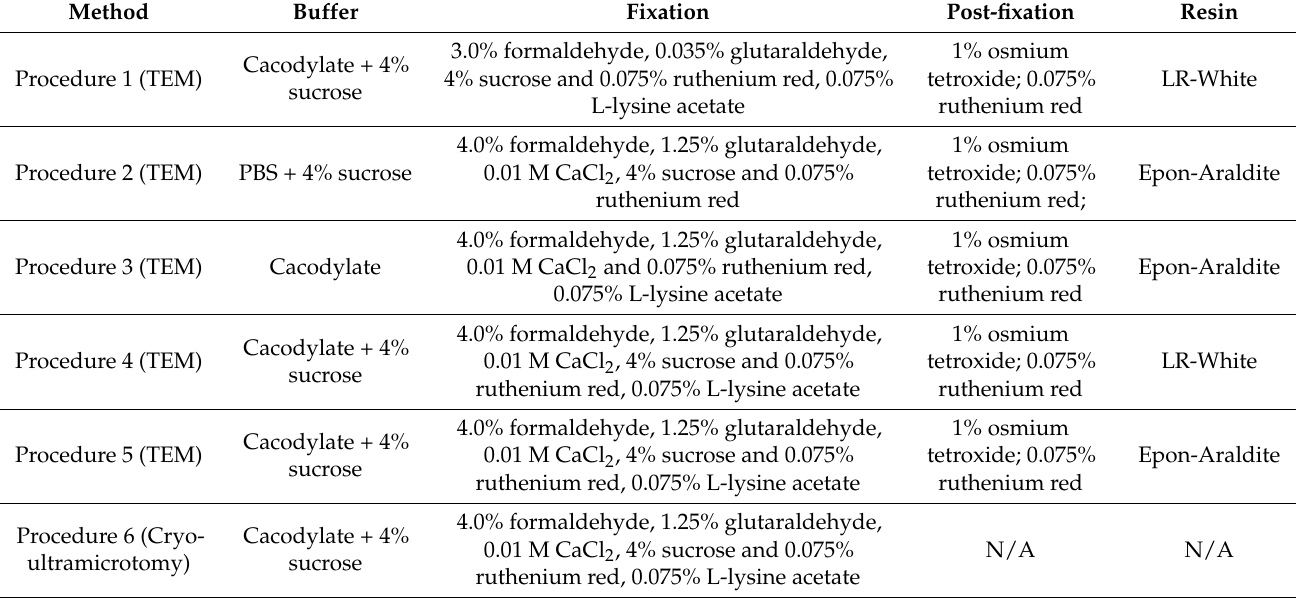
Table 1. Optimization of sample preparation for TEM and